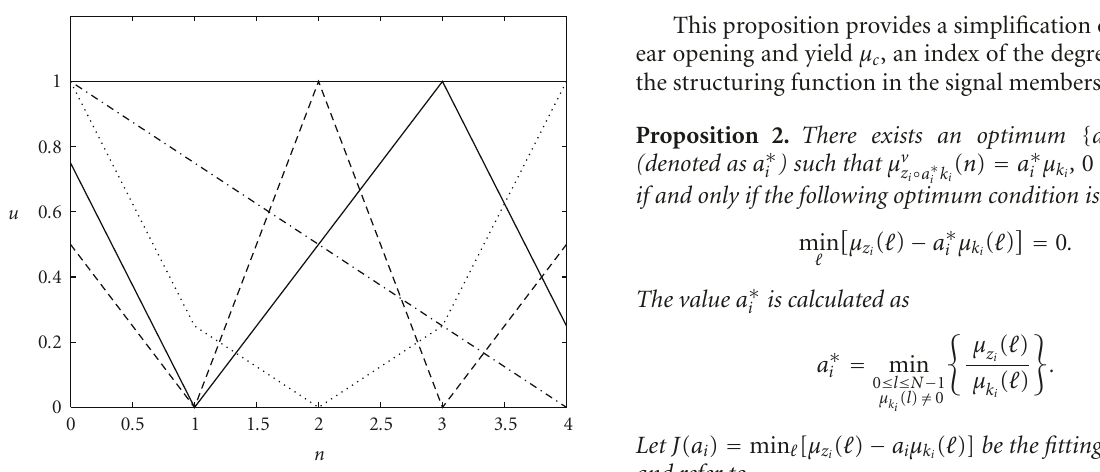
Figure 3: Fuzzy structuring functions using DLO polynomials for N =